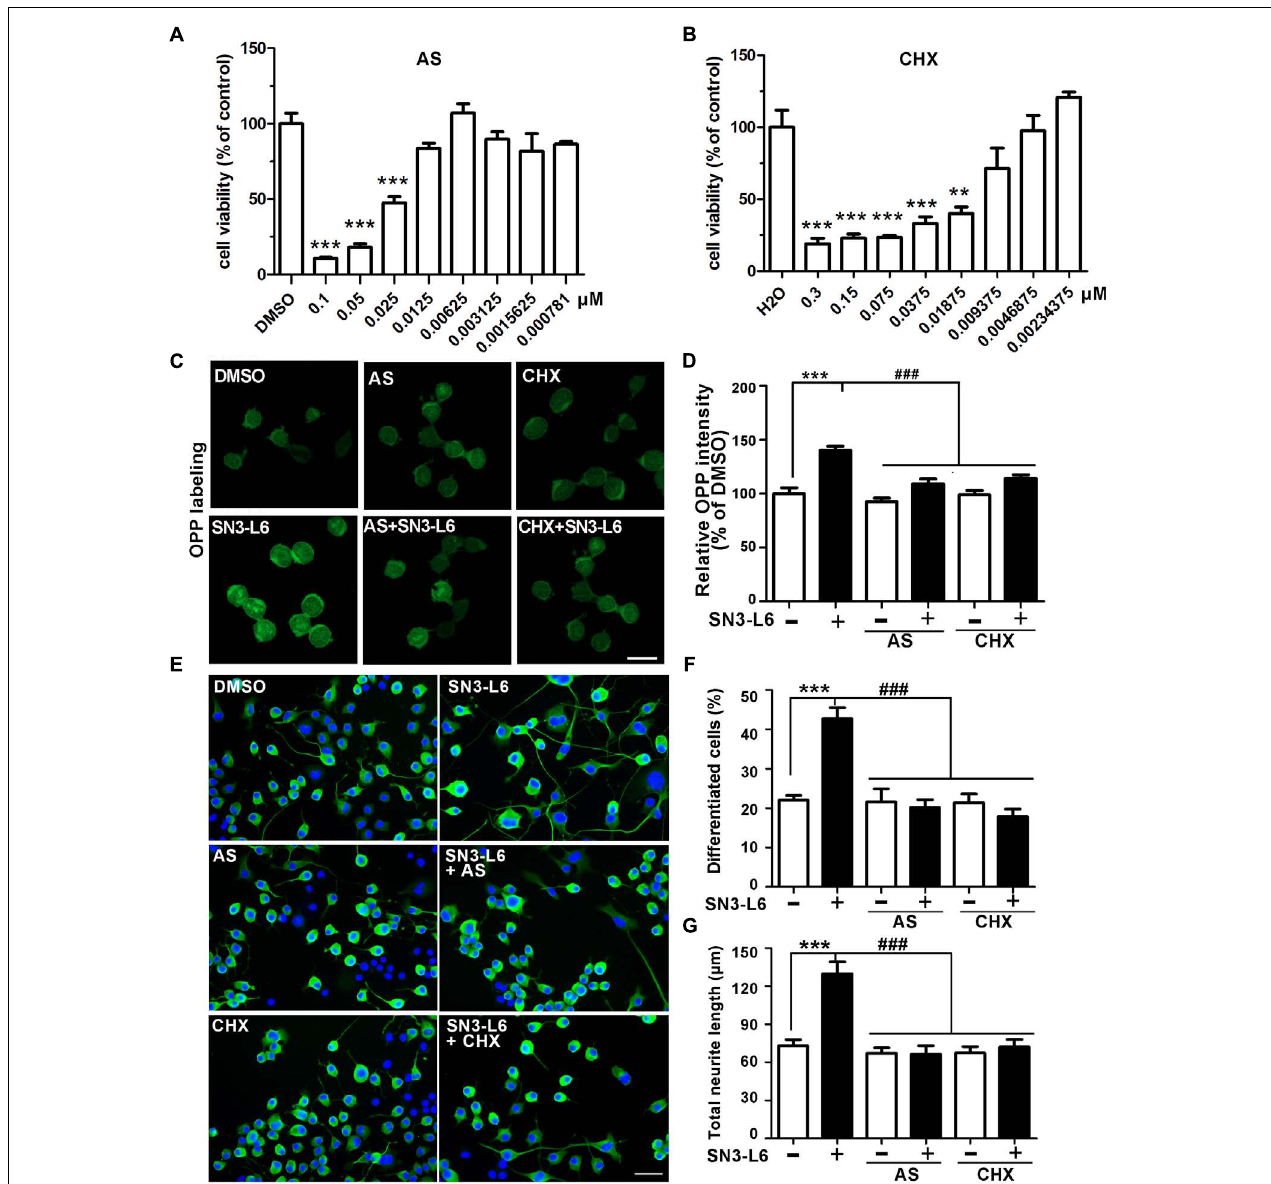
FIGURE 5 | Neuronal differentiation induced by SN3-L6 depends on translation. Neuro-2a cells were treated with different concentrations of AS (A) and CHX (B) for 48 h. Cell viability was performed by MTT assay. ∗∗∗ P < 0.001, ∗∗ P < 0.01, AS vs. DMSO or CHX vs. H 2 O. (C) Representative images of OPP labeling of newly synthesized polypeptides treated with SN3-L6 together with AS (12.5 nM) or CHX (9 nM). Scale bar, 20 µ m. (D) Quantification of OPP signal intensity. ∗∗∗ P < 0.001, SN3-L6 vs. DMSO; ### P < 0.001, AS or CHX vs. SN3-L6. (E) Representative images of Neuro-2a cells treated with SN3-L6 (25 µ M), AS (12.5 nM) or CHX (9 nM). Neurites and nuclei were visualized using β -tubulin III antibody (green) and DAPI (blue), respectively. Scale bar, 50 µ m. Percentage of differentiated cells (F) and total neurite length (G) are quantified. ∗∗∗ P < 0.001, SN3-L6 vs. DMSO; ### P < 0.001, AS or CHX single or co-treatment with SN3-L6 vs. SN3-L6. All data shown in this figure are presented as mean ± SEM from at least three independent experiments. Statistical analysis was subjected to one-way ANOVA with Bonferroni multiple comparison